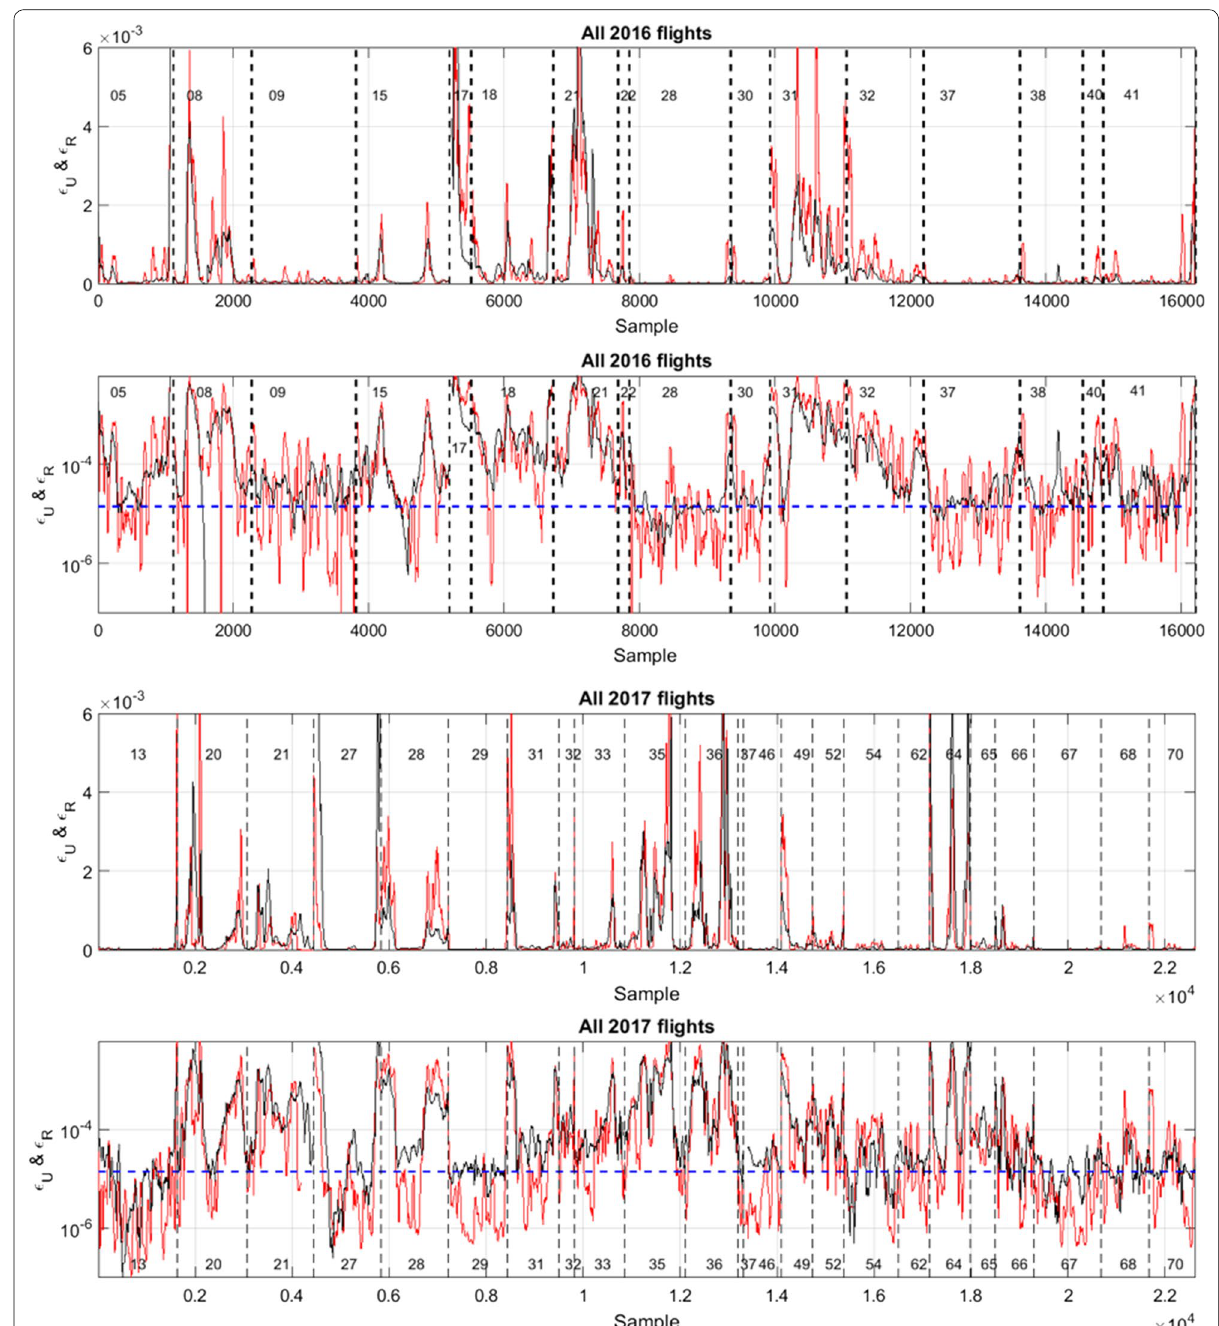
Fig. 9 a Concatenation of all ε U (red) and ε R (black) profiles from the 2016 UAV flights in chronological order (the vertical dashed lines show the transition between the flights). (Top) linear scale. (Bottom) logarithmic scale. The blue dashed line shows the minimum level (~ 1.6 × 10 − 5 m 2 s − 3 ) detectable by the radar according to Fig. 3. b Same as a for the 2017